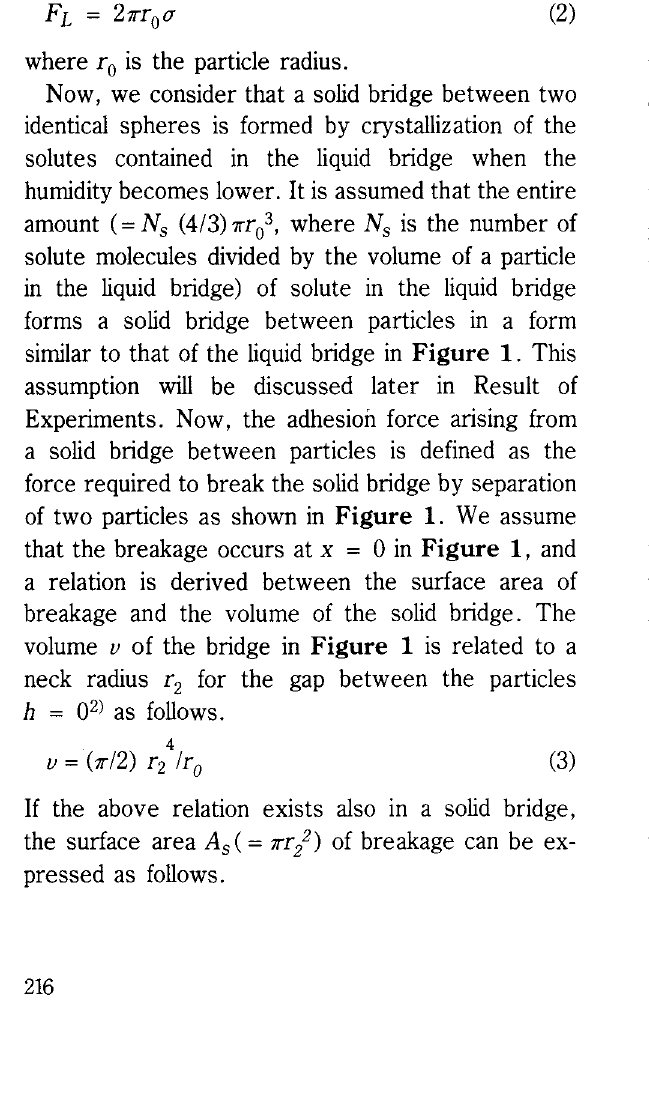
Fig. 1 Dimensions of liquid bridge between two spheres the liquid bridge, which depends on the size and profile of the bridge determined in the above manner. mined by the type and amount of solutes, the sur rounding humidity, the size of the particles, the distance between the particles and the like. When a large liquid bridge is formed because of a large amount of solutes contained in the liquid bridge, or bridge can be considered ash = 0, for a liquid bridge formed between two spheres of identical size,